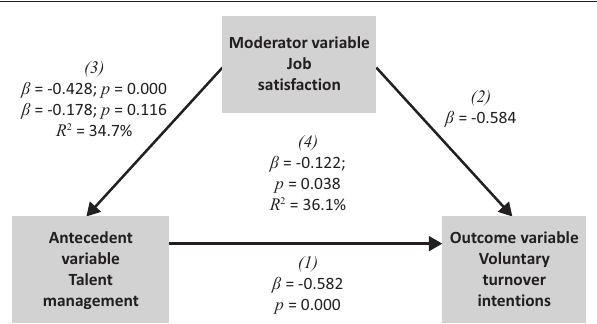
FIGURE 1: Regression analyses: Talent management, job satisfaction and voluntary turnover